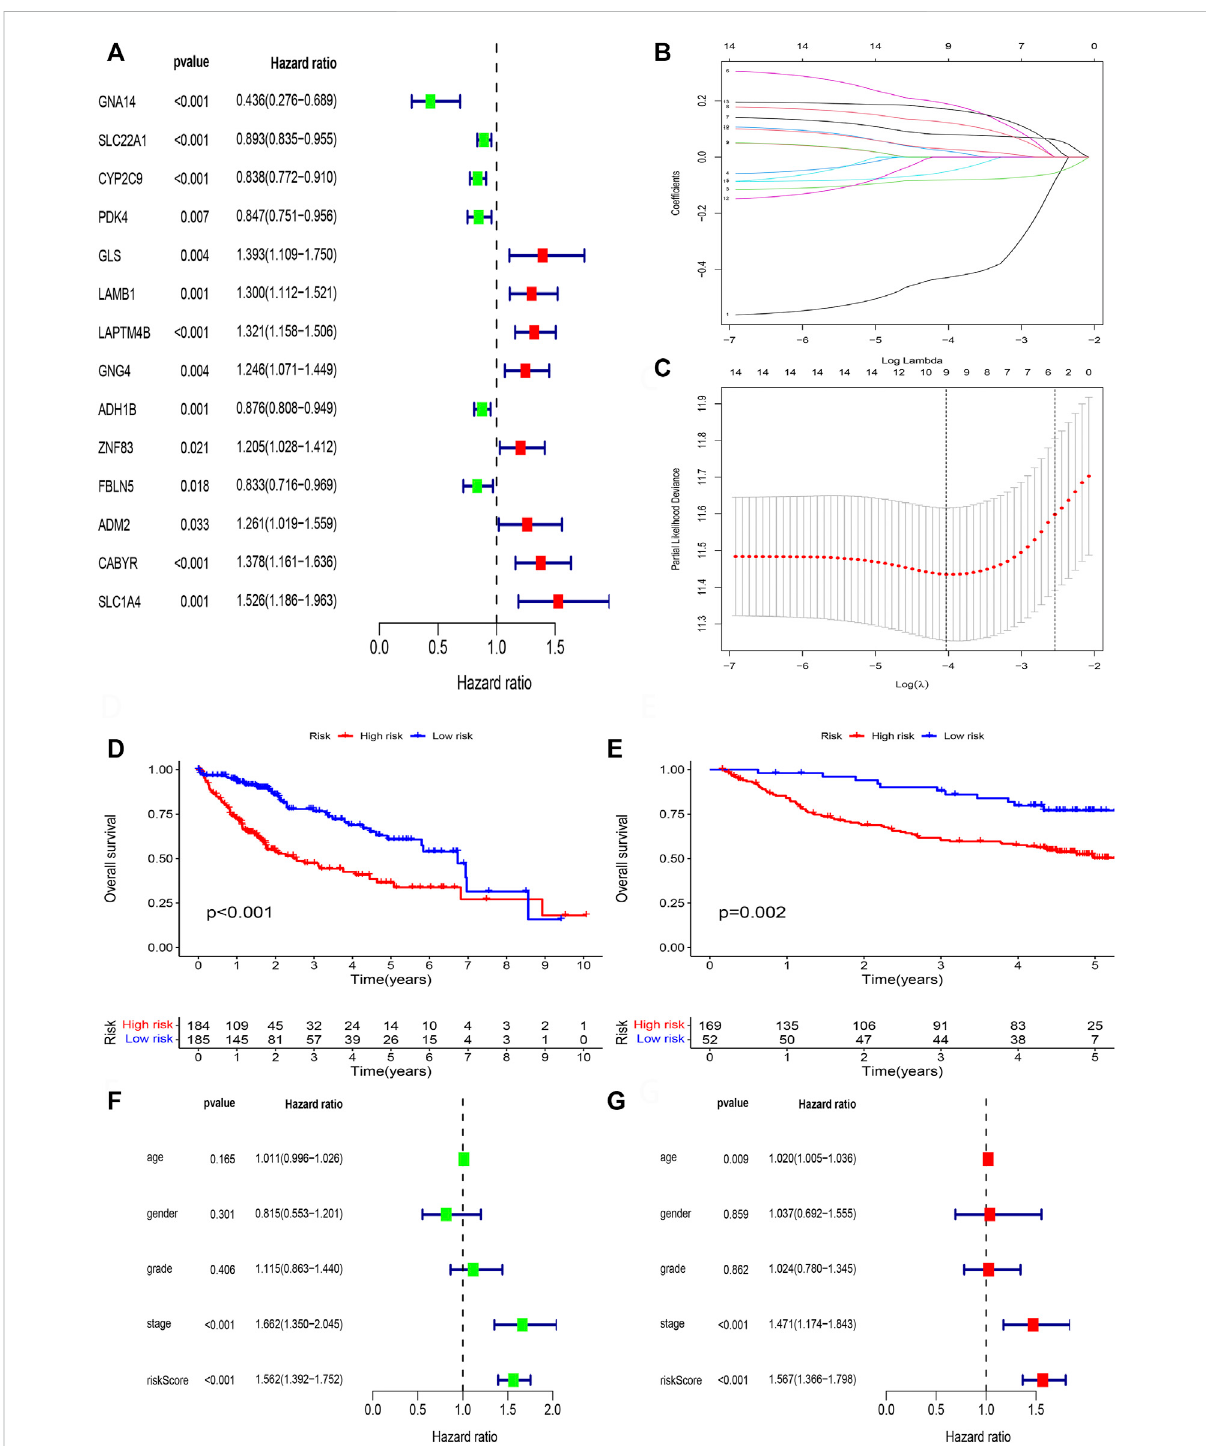
FIGURE 6 Lasso regression analysis. (A) The univariate cox regression analysis of 31 DNA methylation-driven genes. (B) LASSO coef fi cient distribution of DNAmethylation-drivengenes. (C) Thetuningparameter( λ )intheLASSOmodel. (D) Survivalcurveofthetworiskgroupsderivedfromthe fi ve-gene signature in the TCGA cohort. (E) Survival curve of the two risk groups derived from the fi ve-gene signature in the GSE14520 cohort. (F) Univariate Cox regression analysis of risk scores and clinical features. (G) Multivariate Cox regression analysis of risk scores and clinical